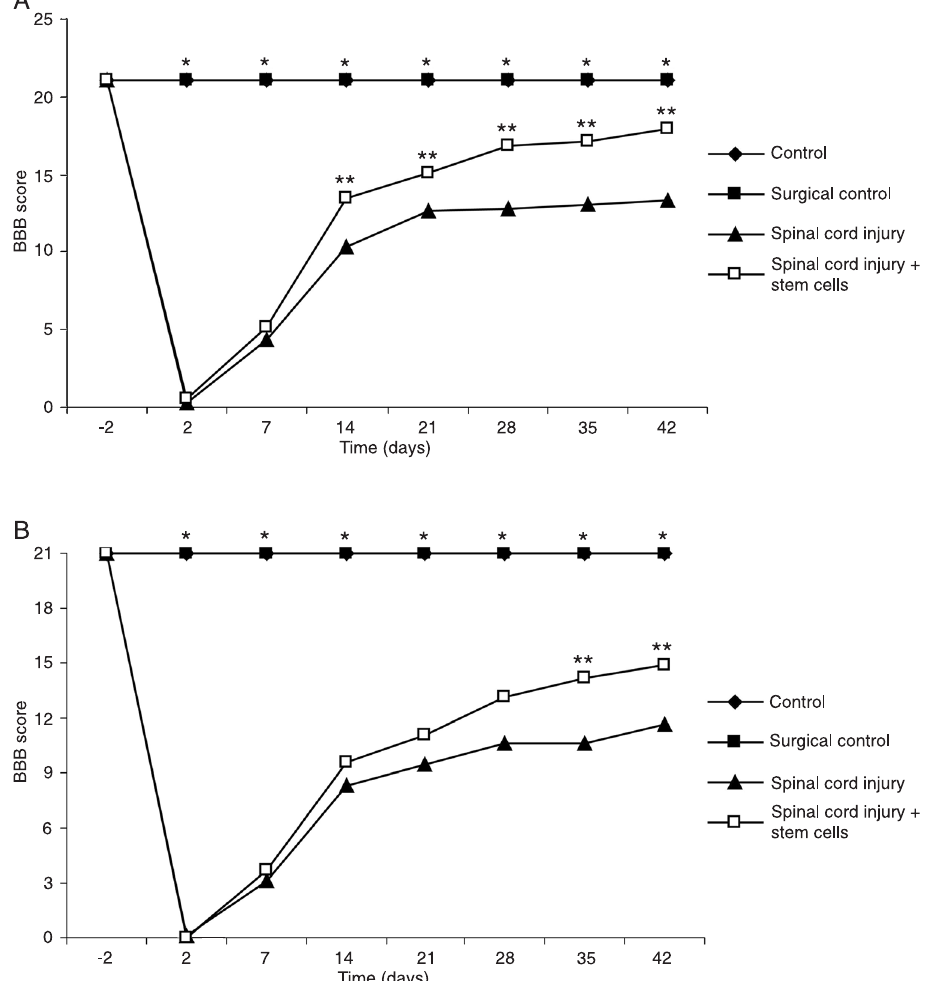
Figure 1. Basso, Beattie and Bresnahan (BBB) locomotor rating scale scores after treatment with mono- nuclear cells 1 h ( Panel A ) and 9 days ( Panel B ) after rat spinal cord injury. Data are reported as means ± SD for 8-14 rats in each group. BBB scale, scores range from 0 (complete paralysis) to 21 (normal gait). *P ≤ 0.05 for the control and sham groups compared to the injured and treated groups. **P ≤ 0.05 for the injured group compared to the treated group (ANOVA followed by the Mann-Whitney